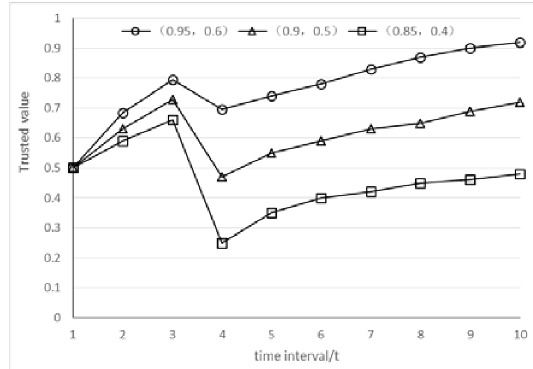
Fig. 4. The trusted value with different parameter